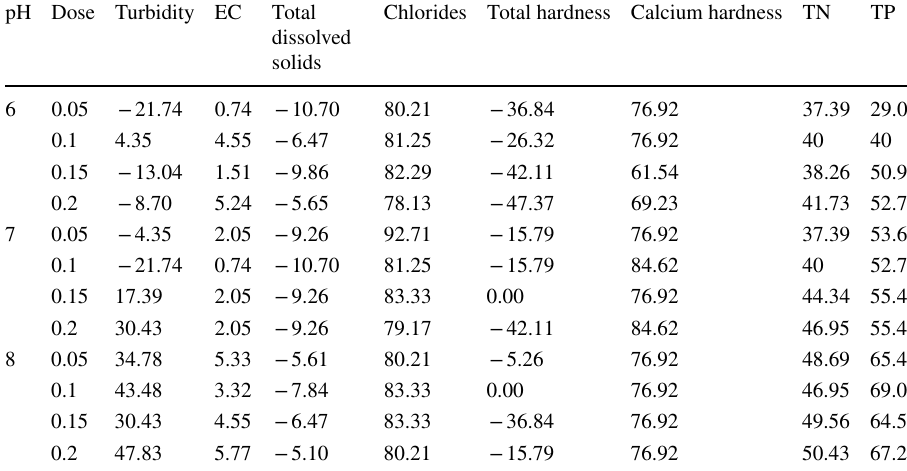
pH Dose Turbidity EC